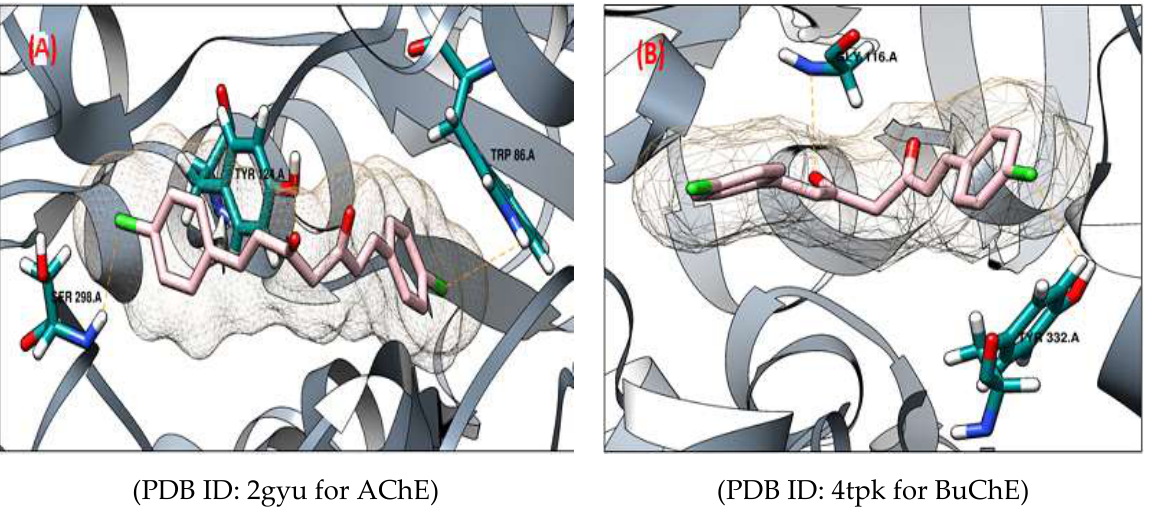
Figure 2. 3D binding mode of compound ( 1d ) against cholinesterase ( A ) AChE and ( B ) BuChE pro- tein.